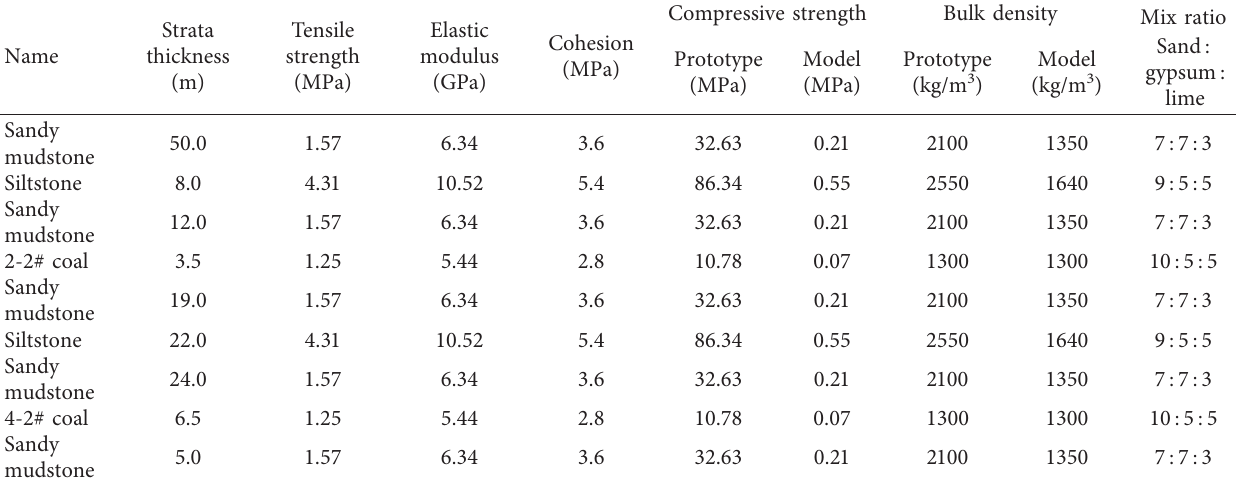
Table 2: Physical-mechanical parameters of coal rocks and mix ratios of rock similar